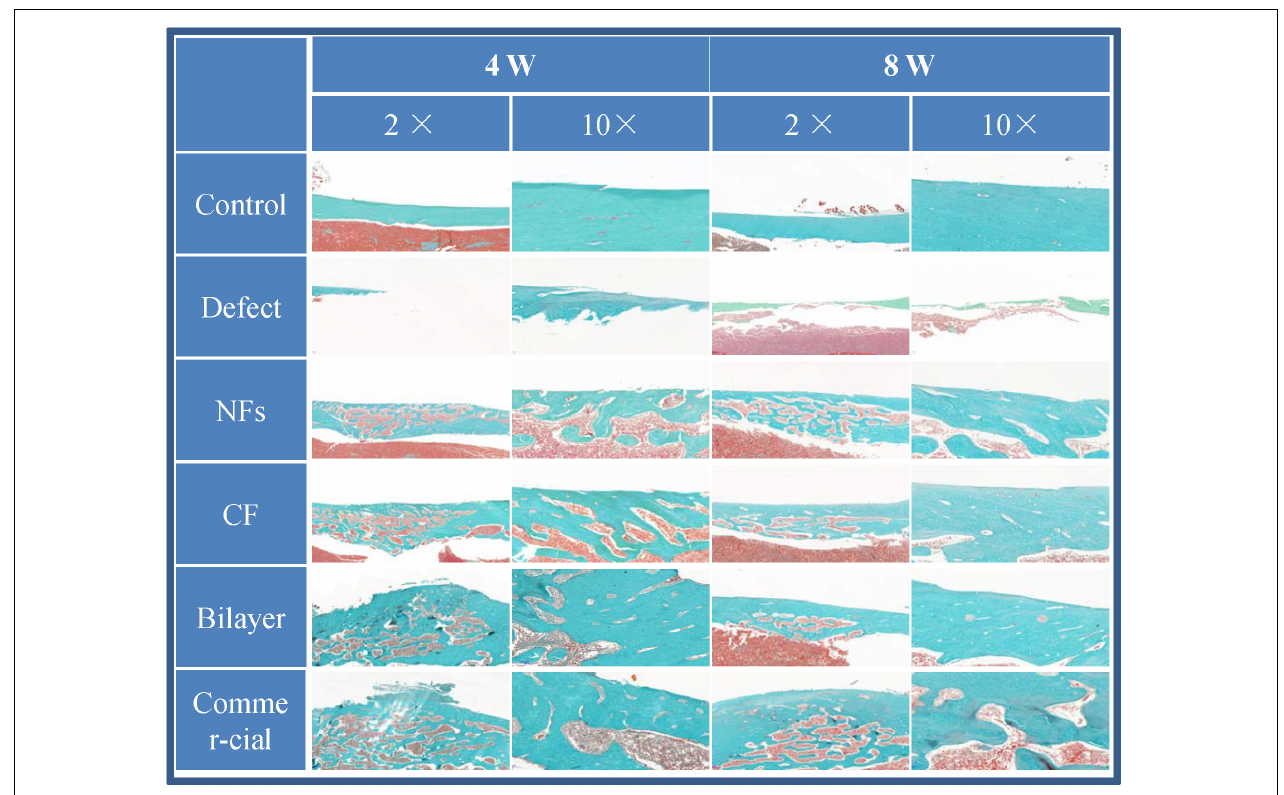
FIGURE 11 | Goldner’s trichrome staining of the bone defect after 4 and 8 weeks of